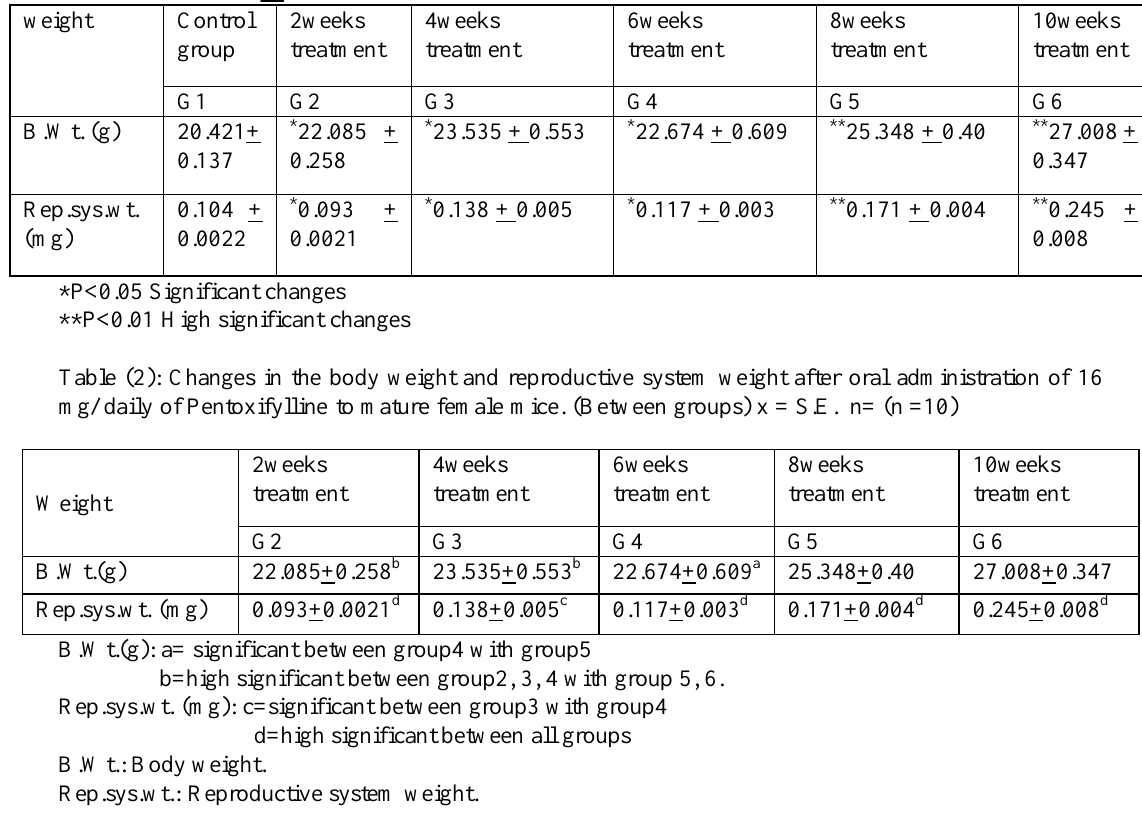
Table (3): Shows the effects of daily 16 mg of PTX on hormonal serum level in female mice x = S.E. n= (n =6)